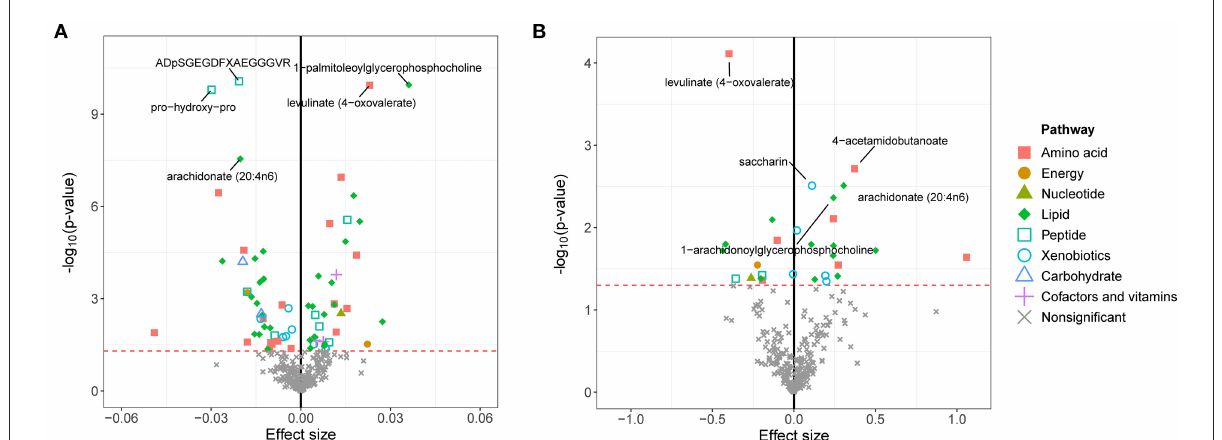
FIGURE2 GRS associations between serum metabolites and eBMD (A) or fracture (B) . The x-axis represents the effect size, and the y-axis represents the –log 10 ( p ). Five top metabolites with minimal q-values were annotated. Significantly associated metabolites ( p < 0.05) were marked with corresponding pathway information. eBMD, estimated bone mass density.